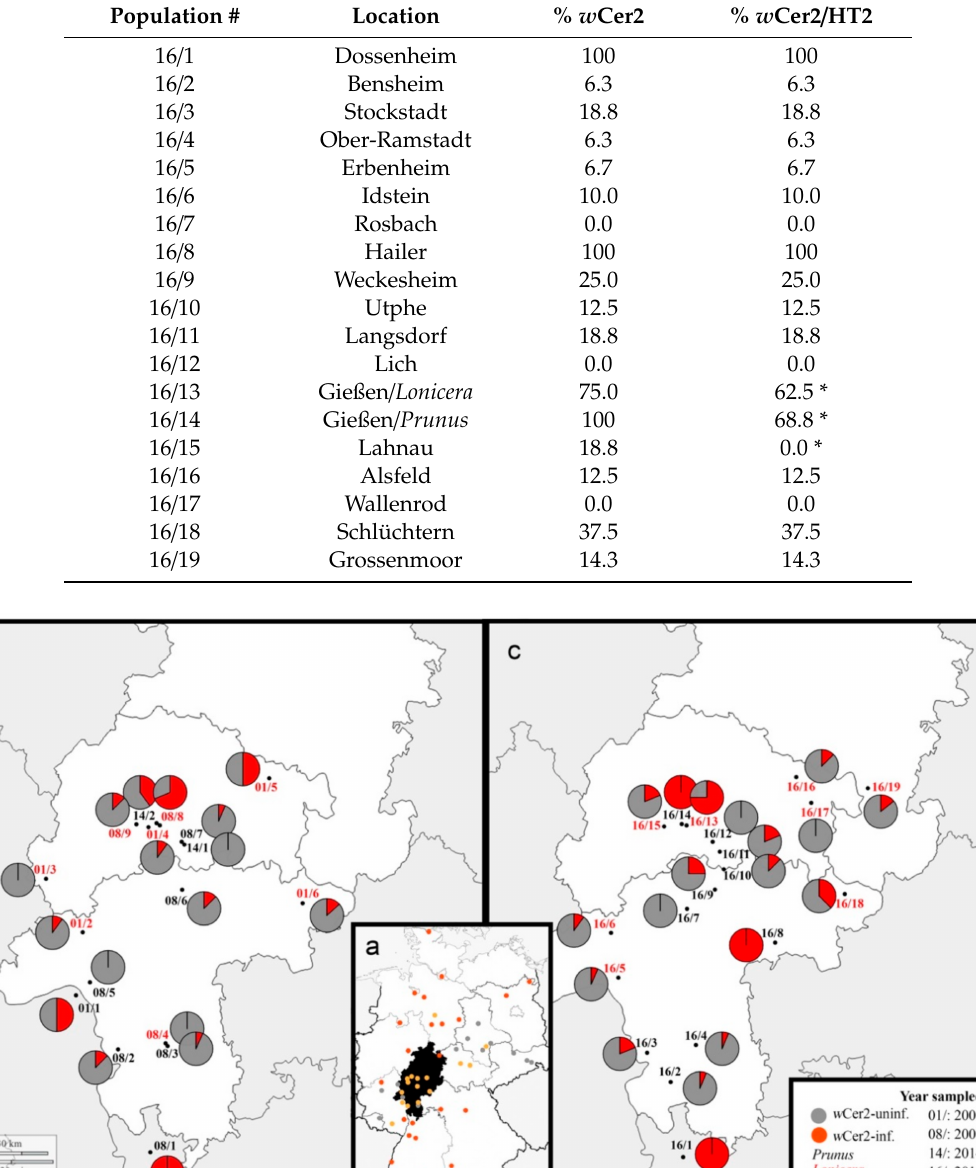
Table 1. Infection frequencies of w Cer2 across di ff erent R. cerasi populations and ratios of w Cer2-infected flies associated with haplotype 2 (HT2) per population (* = populations with Wolbachia -haplotype misassociations).